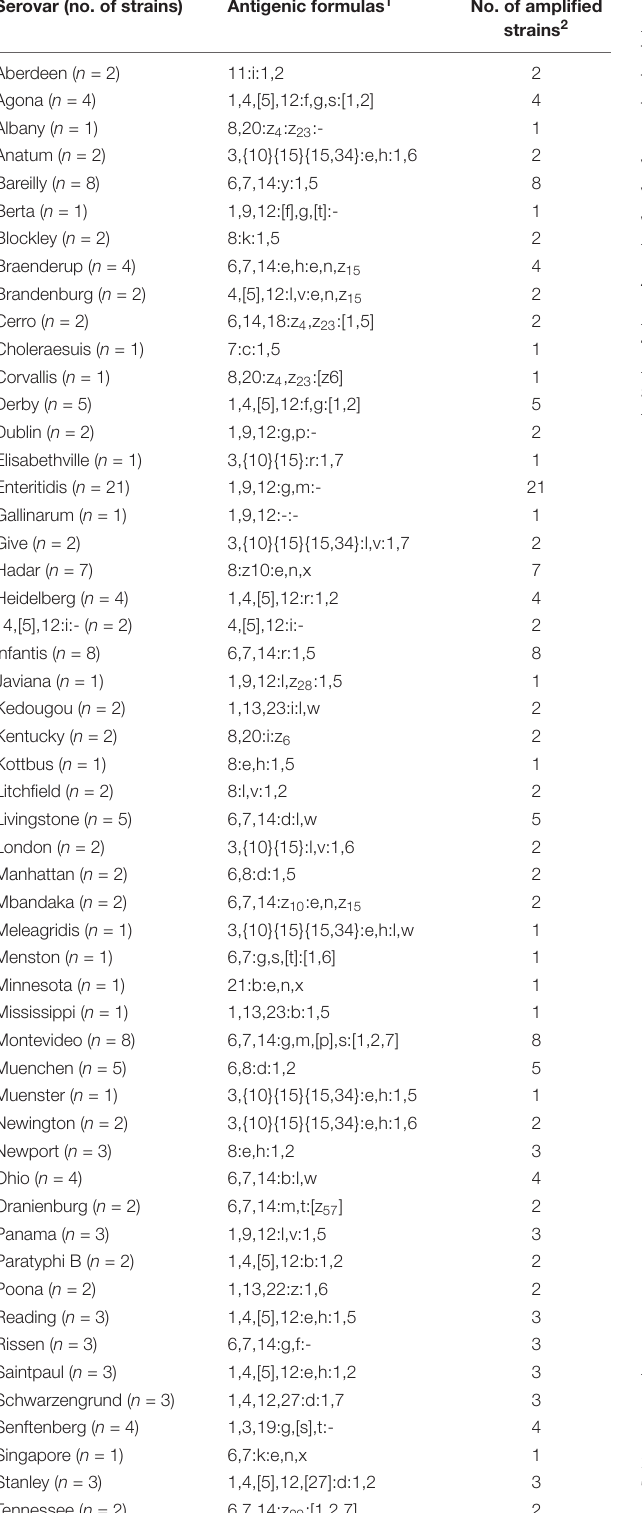
TABLE 4 | Comparison of serotyping results through antisera aggregation and real-time PCR. Serovar (no. of strains) Antigenic formulas 1